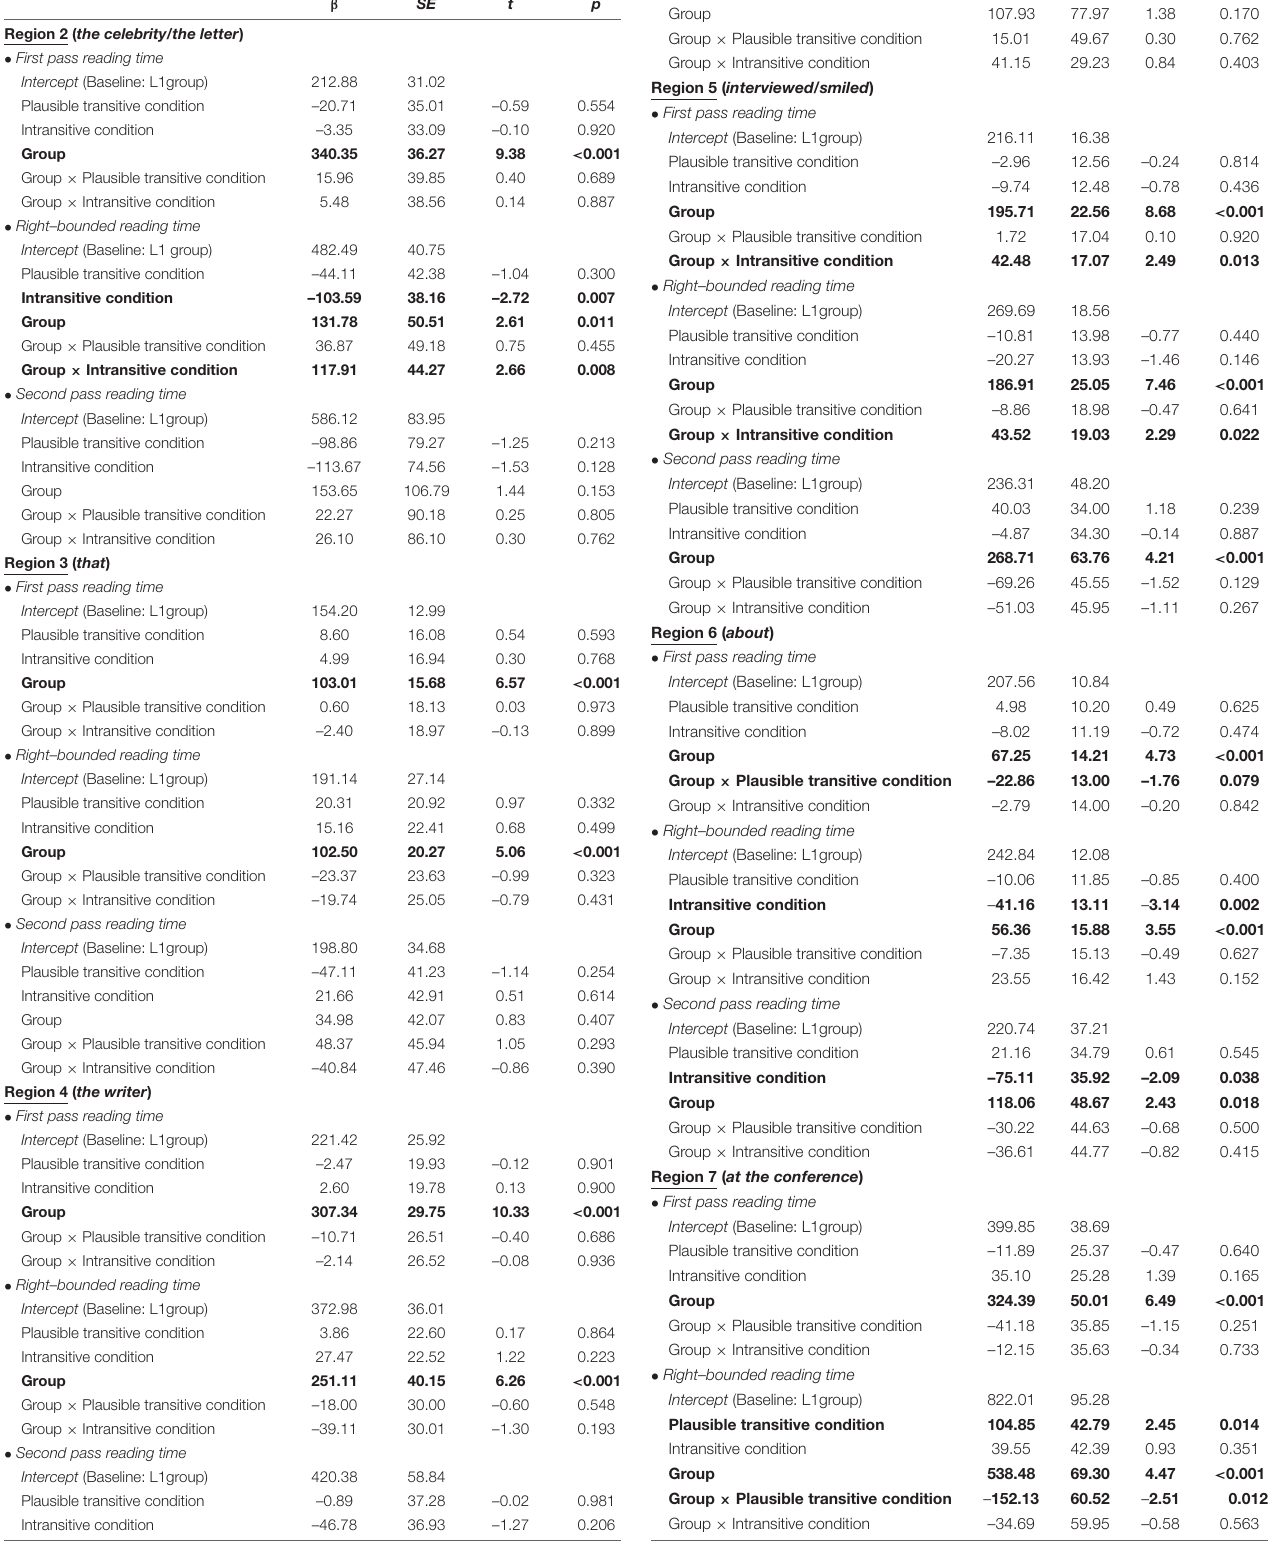
The results with p-values less than 0.05 are shown in